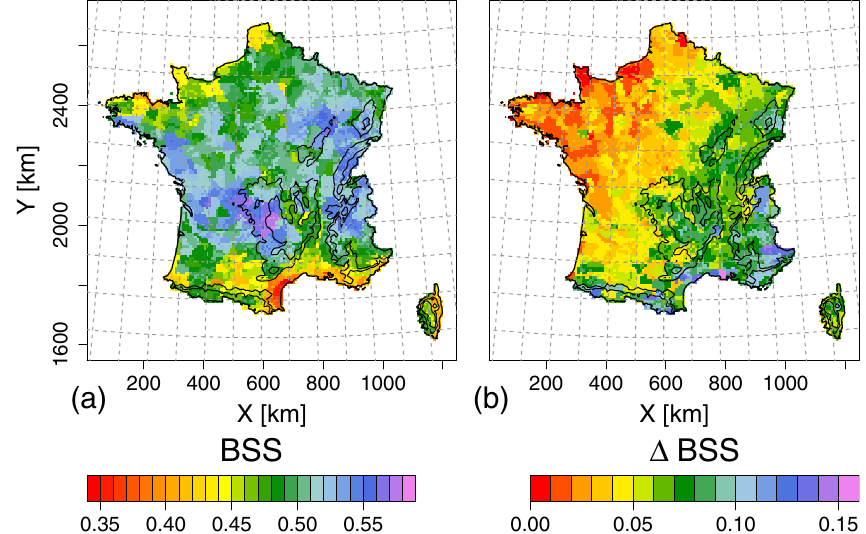
Figure 3. (a) BSS obtained with SCAMP (best possible value = 1). (b) BSS gain obtained with SCAMP compared to AM 25 . Black solid lines correspond to the French borders and the contours around mountainous regions (400 and 800m elevation), while the dashed lines show the ERA-40 grid mesh.